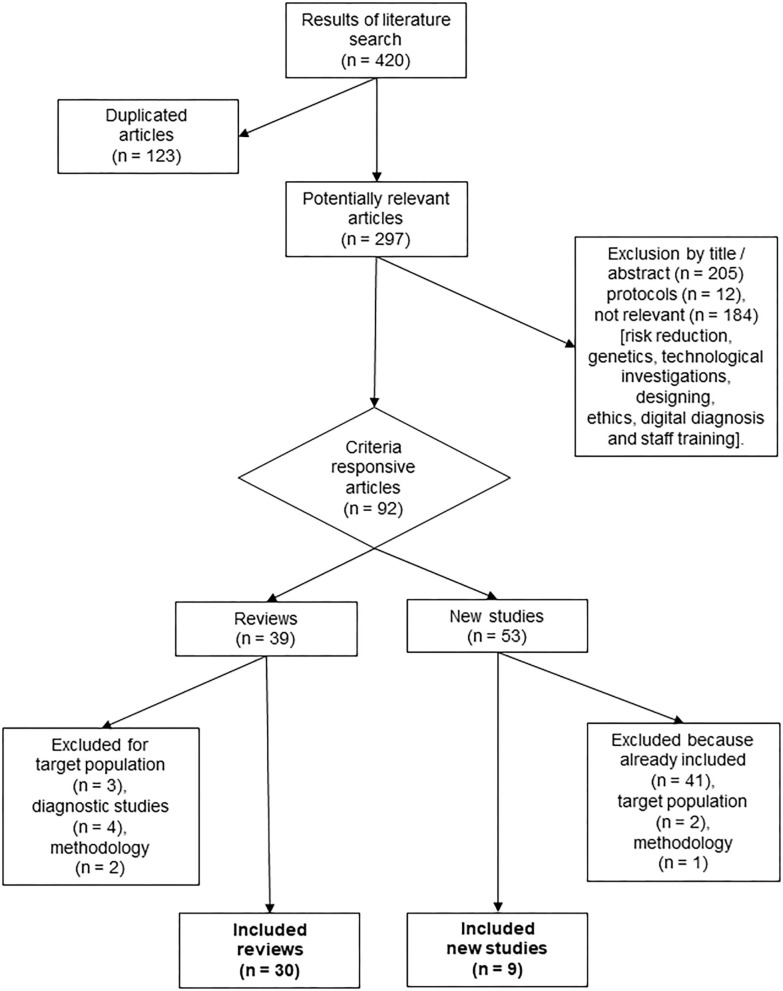
Revision flow chart.